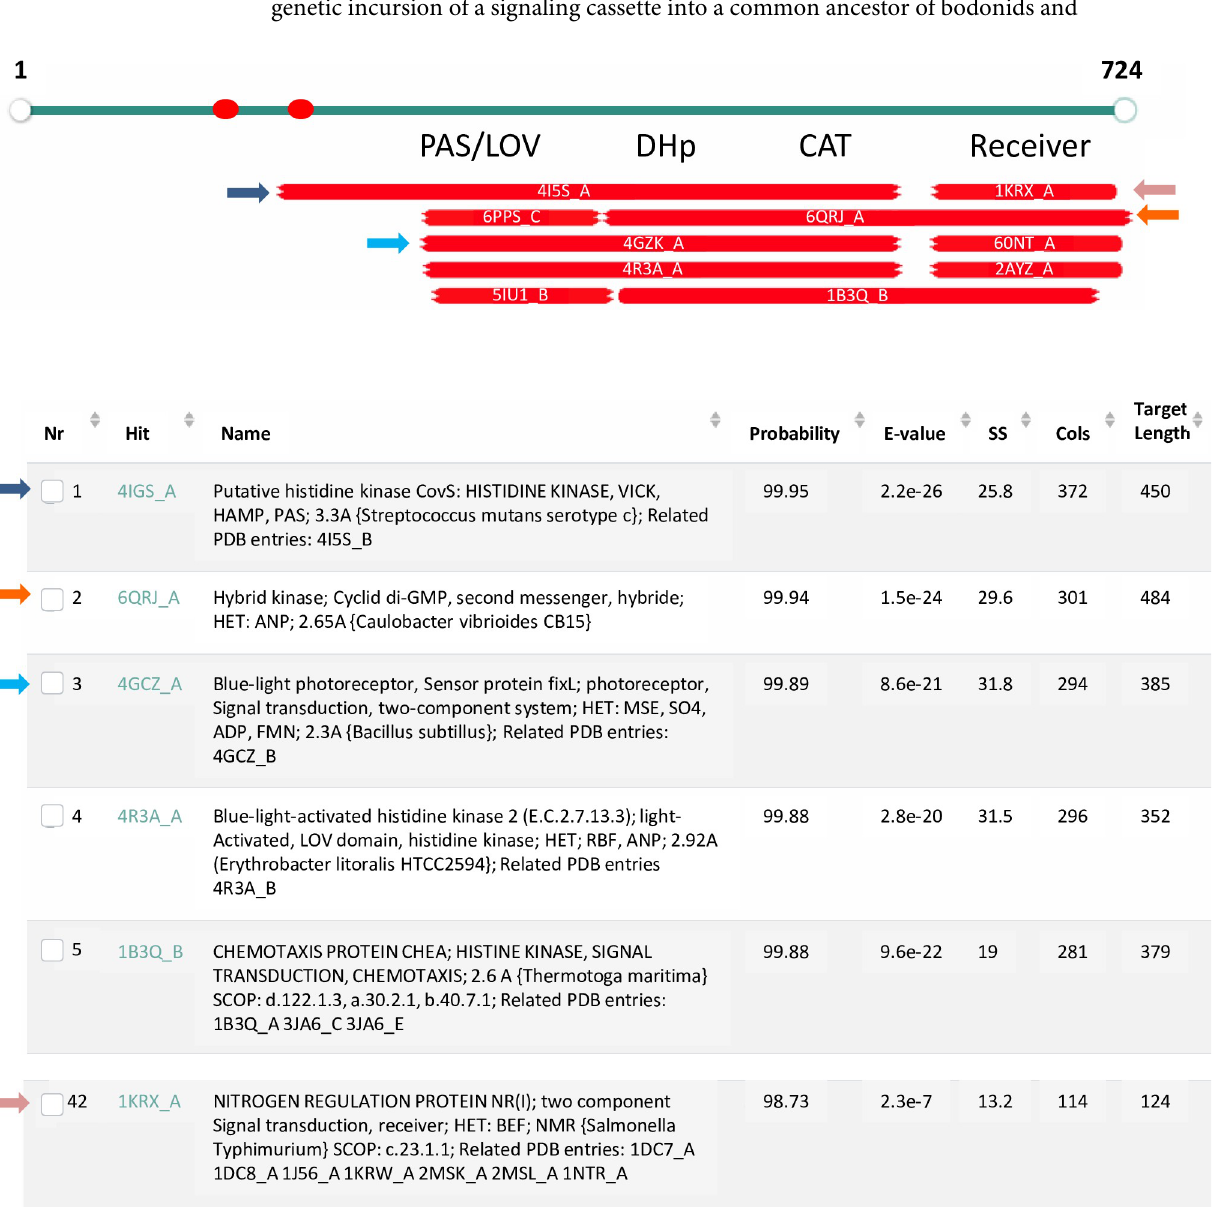
Fig 2. HHpred analysis of Tb927.9.3120 shows evidence of ancient domains. The PK domain (aa 737–980) is not shown. Red ovals–transmembrane domains predicted by TMHMM and CCTOP. Each bar below the gene model represents the top hits by HHpred. The color of the arrows mark descriptions matching the hits. The description includes the PDB number and chain designation (Hit), a description of the PDB entry including related PDB entries (Name), the probability of the hit based on the Hidden Markov Model (Probability), the probability of the match in an unrelated database (E- value), score for the secondary structure prediction (SS), number of amino acids aligned (Col), and the total length of the target in PDB (Target Length). The documentation for HHpred considers “Probability" the most important criterion with our hits meeting at least one of the two most stringent criteria: having a score > 95% or having a score > 50% and making reasonable biological sense